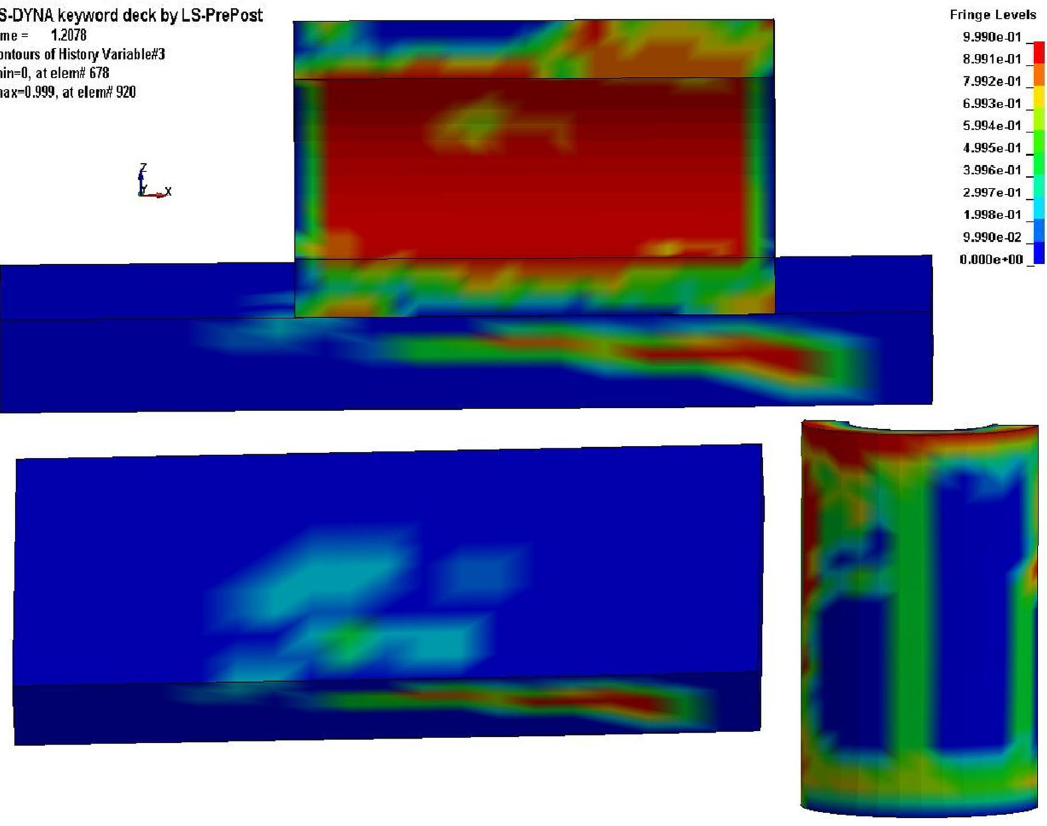
Fig. 24 Contours of ductile damage at the time of impact.